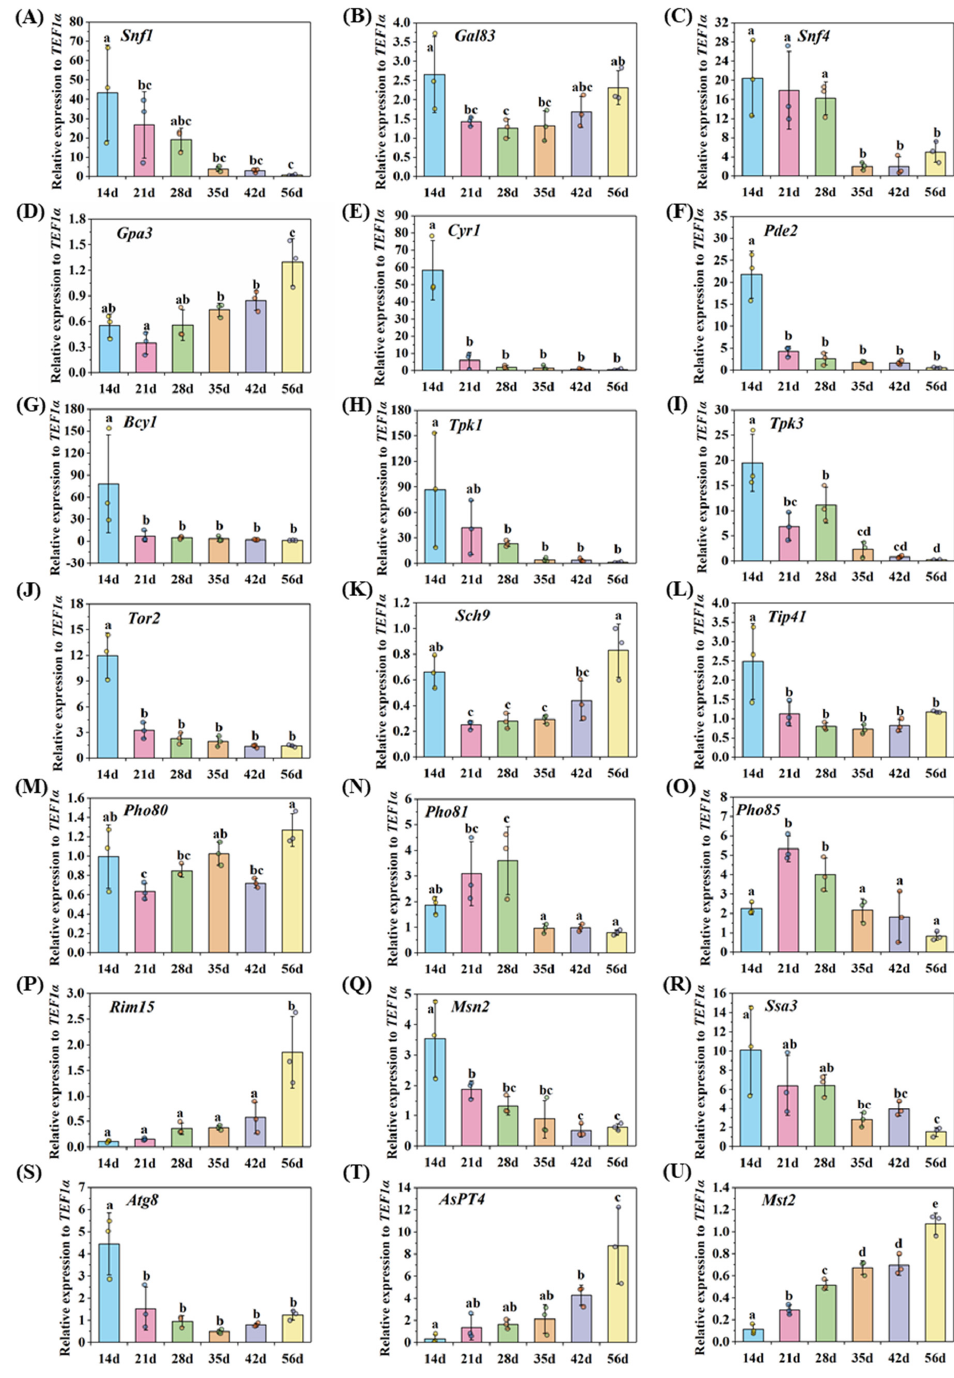
Figure 3. The expression patterns of the key AM fungal genes involved in the nutrient signaling pathways and symbiotic marker genes in the A. sinicus mycorrhizal roots 14, 21, 28, 35, 42 and 56 days (d) post inoculation with R. irregularis . ( A – U ) The transcript levels of target genes were estimated by real time qRT-PCR. ( A – C ) Snf1 , Gal83 and Snf4 in the SNF1 pathway. ( D – I ) Gpa3 , Cyr1 , Pde2 , Bcy1 , Tpk1 and Tpk3 in the cAMP-PKA pathway. ( J – L ) Tor2 , Sch9 and Tip41 in the TOR pathway. ( M – O ) Pho80 , Pho81 and Pho85 in the PHO pathway. ( P – S ) The common targets Rim15 , Msn2 , Ssa3 and Atg8 . ( T – U ) The symbiotic marker genes AsPT4 and RiMst2 , whose expression patterns indicate the arbuscular mycorrhizal development. The RiEF1 α ( translation elongation factor 1 α in R. irregularis ) was used as the reference gene for normalization of AM fungal genes expression, while AsActin ( β -actin in A. sinicus ) was used as the reference gene for normalization of the A. sinicus gene AsPT4 expression. Error bars represent the means of three biological replicates with ± SD values. Different letters indicate significant differences at p < 0.05, according to the Duncan’s